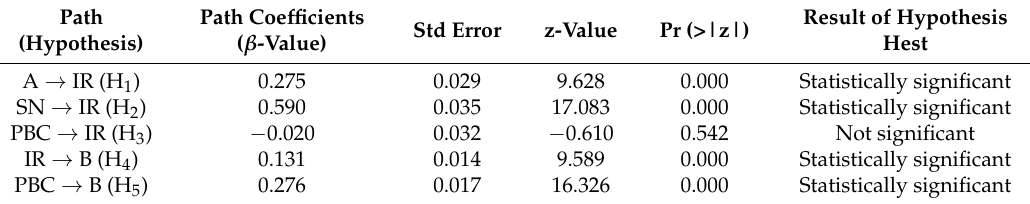
Table 9. Parameter estimates for applying the TPB.